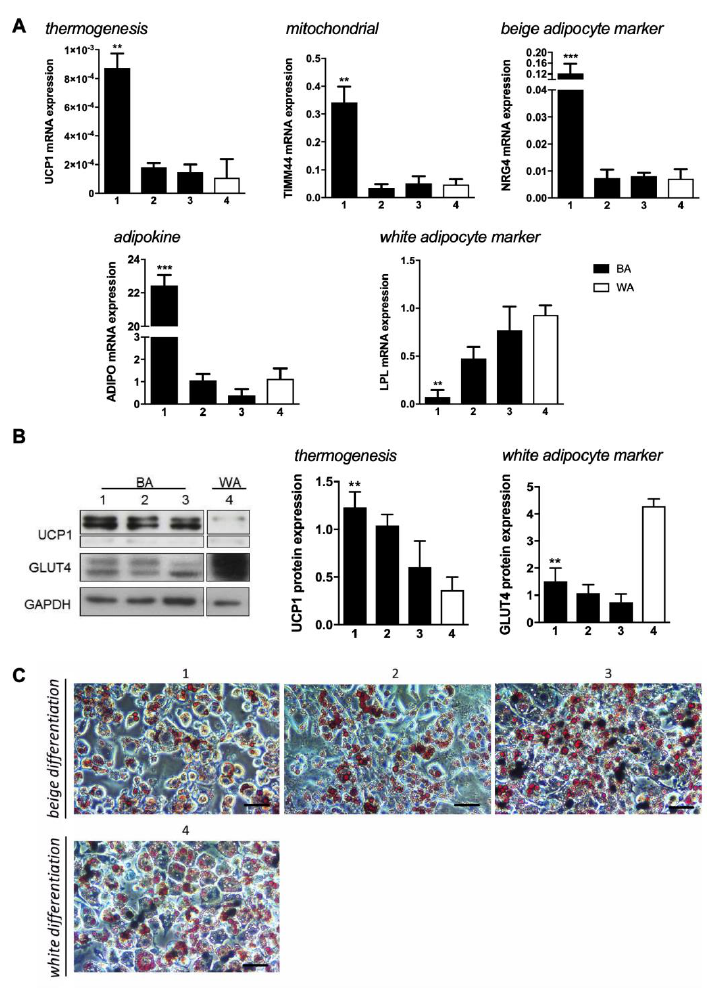
Figure 1. Beige and white adipocyte markers expression and their modulation by four di ff erentiation-inducing cocktails in 3T3-L1 cells. ( A ) Relative expression of UCP1, TIMM44, NRG4, ADIPO, and LPL in 3T3-L1 fibroblasts that were induced to di ff erentiate into beige (1–3; black bars) (BA) and white (4; white bars) (WA) adipocytes. Gene expression values are relative to ARP. ( B ) Representative blots and relative UCP1 and GLUT4 protein expression in 3T3-L1 fibroblasts that were induced to di ff erentiate into beige (1–3; black bars) and white (4; white bars) adipocytes in relation to Glyceraldehyde 3-phosphate dehydrogenase (GAPDH). ( C ) Lipid droplets characterization by triacyclglycerols staining with Oil Red O expression in 3T3-L1 fibroblasts that were induced to di ff erentiate into beige and white adipocytes. Scale bar = 20 µ m. Data represent mean ± SEM of three independent experiments. * p < 0.05, ** p < 0.01, *** p <